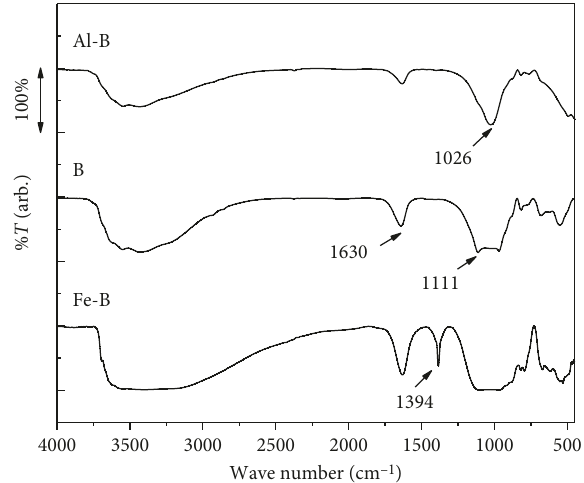
Figure 2: FTIR spectra of B, Fe-B, and Al-B.